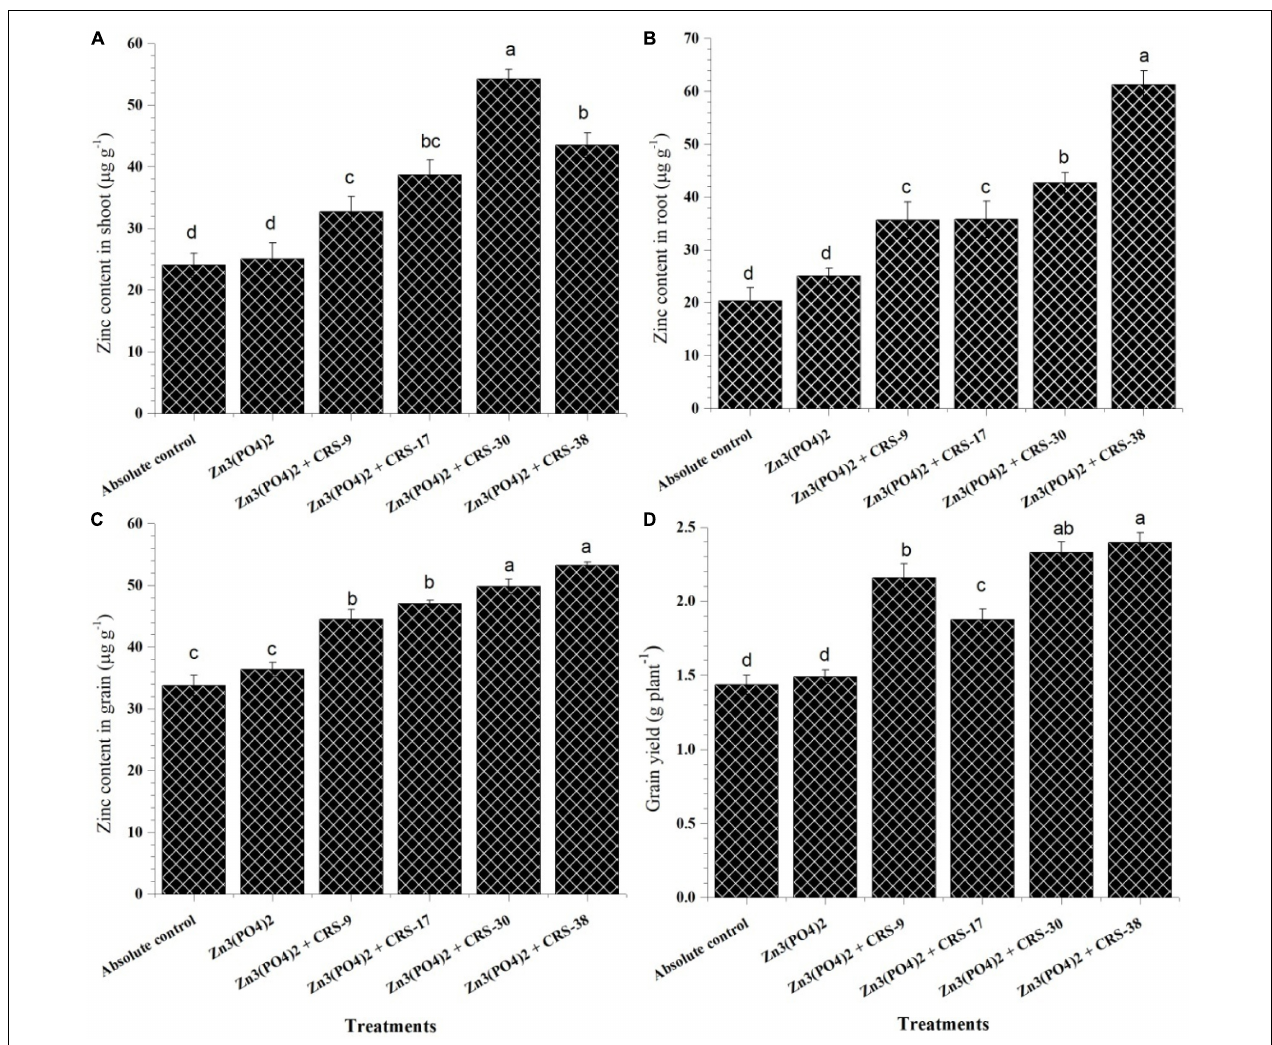
FIGURE 8 | Estimation of zinc content in (A) shoots, (B) roots, (C) grains, and (D) grain yield of inoculated and un-inoculated plants harvested after 120 days (second set). Data are mean ( n = 5) and vertical bar represents standard deviation. Data with different letters show significant difference in column data in randomized block design test at p < 0 : 05 under Duncan’s multiple range